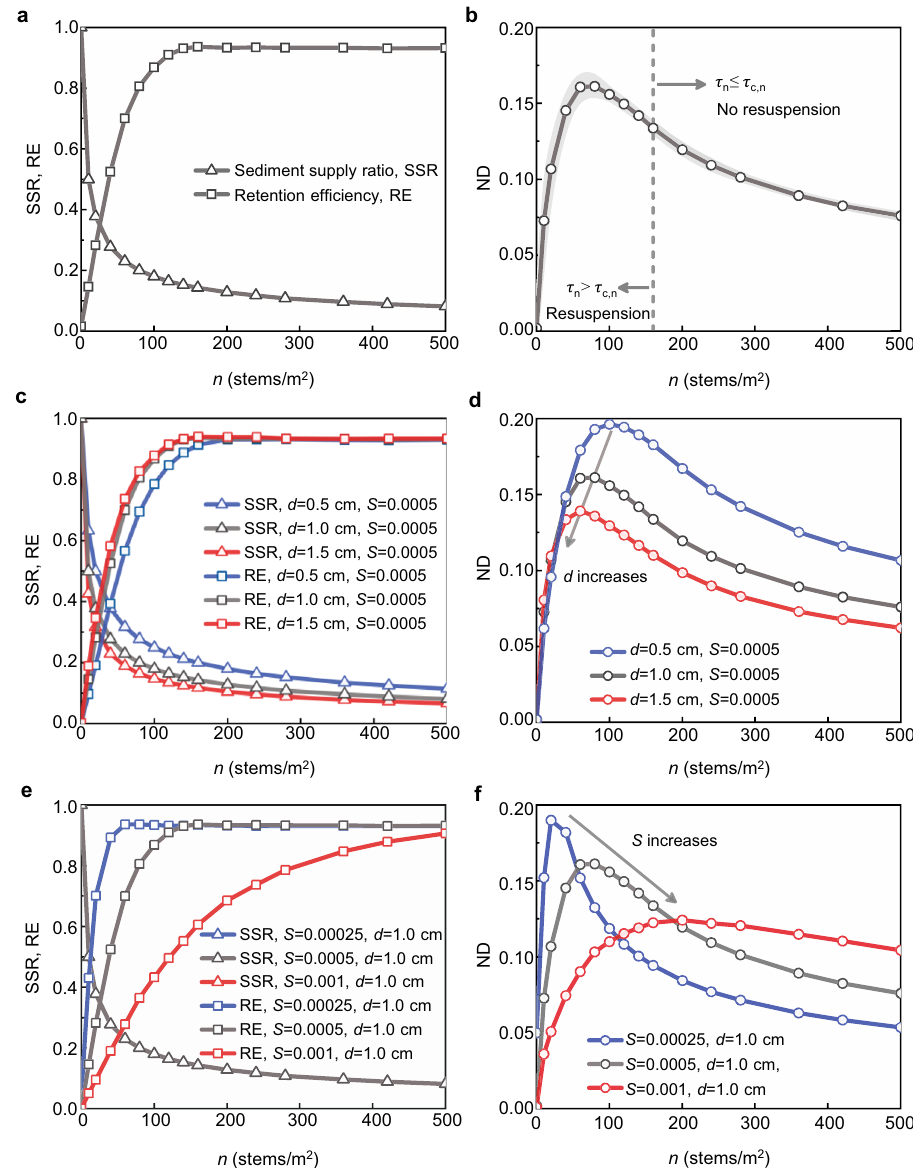
Fig.3|Modeledsedimentation(netdeposition)withvegetationareadensity n . SSR is sediment supply ratio, triangles (Eq.1). RE is retention ef fi ciency, squares (Eq.2).NDisnormalizednetdeposition,circles(Eq.3).Basecasesin a and b ,varied stem diameter d in c and d , and varied slope S in e and f . Blue to gray to red color correspondstoincreasingdiameterorslope.In b verticaldashedlineat n =160m − 2